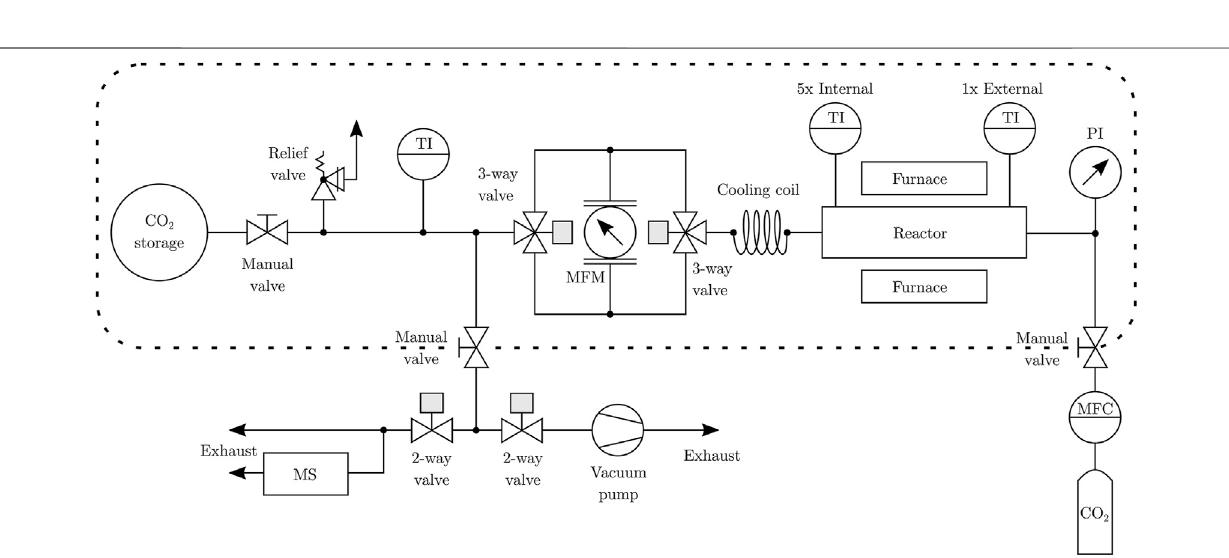
Frontiers in Energy Research |